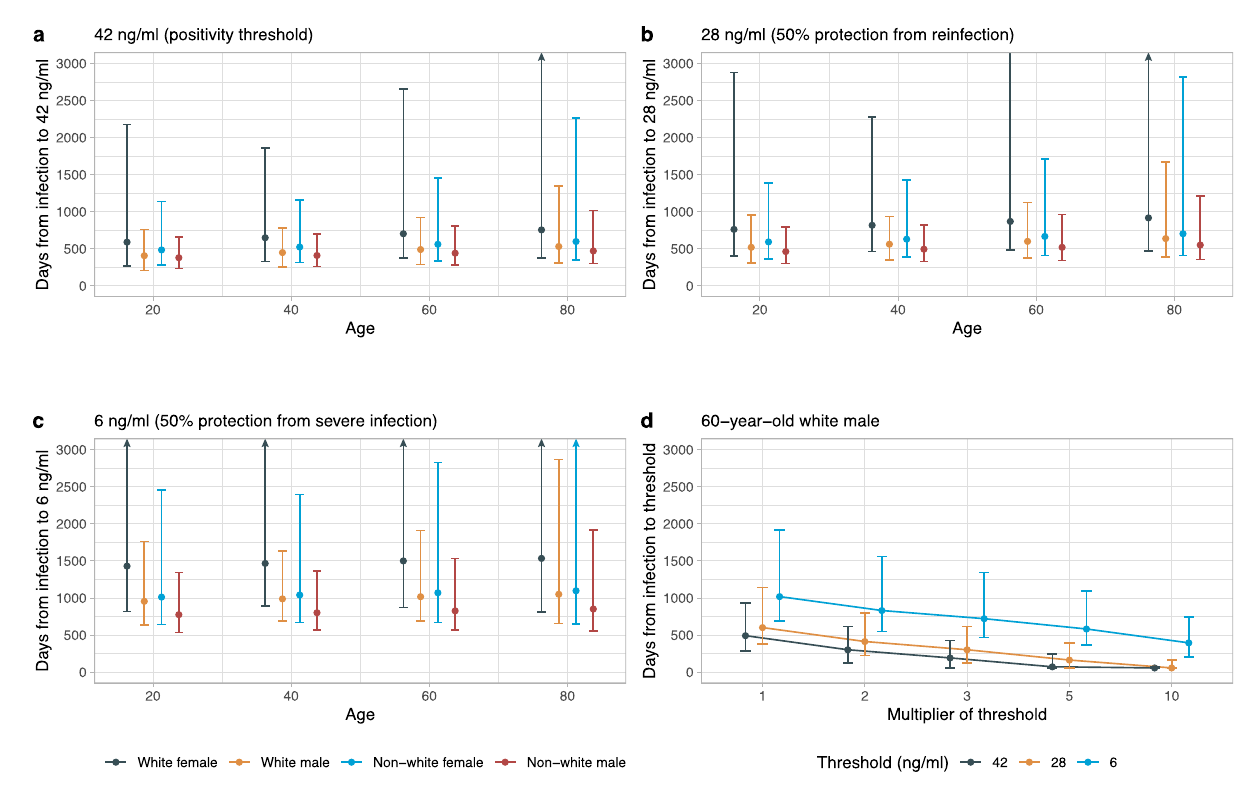
Fig. 5 Posterior predicted time (95% credibility interval) of the start of infection to three anti-spike IgG thresholds (42, 28 and 6 ng ml − 1 ) by age (20, 40, 60 and 80 years), sex, and ethnicity from the multivariable biphasic exponential model in 3271 participants. a Time from the start of infection to the positivity threshold of 42 ng ml − 1 . b Time from the start of infection to the equivocal threshold of 28 ng ml − 1 , which corresponds to 50% protection against PCR-con fi rmed re-infection. c Time from the start of infection to 6 ng ml − 1 , which corresponds to 50% protection against severe infection. d Time from the start of infection to the above three thresholds multiplied by 2, 3, 5 and 10, in a 60-year-old White male as an example, to estimate the duration given the higher antibody level required for protection against variants of concern. Estimations are shown in Supplementary Table 8. Estimates using the linear exponential model are shown in Supplementary Fig. 11 and Supplementary Table